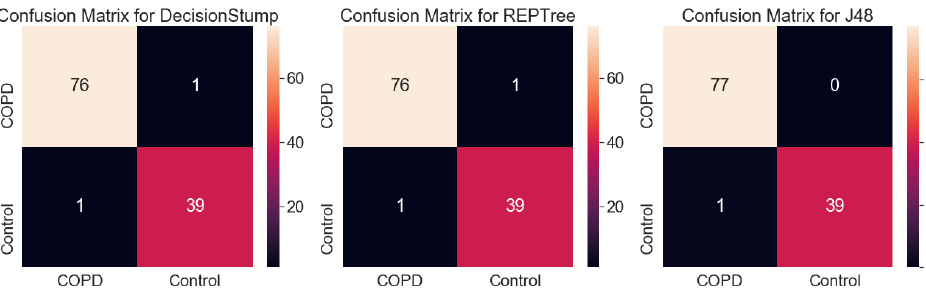
Figure 5. Confusion matrix for results shown in Figure 4. As a result of the experiment using machine learning models, the COPD and control groups of the dataset were classified only according to the expression level of TRPC6, regardless of the values of the other genes, and the accuracy of the best model (J48) was over 99%. This result shows that the classifiers that the decision tree algorithm generated classified COPD patients and controls with simple criteria but high accuracy.